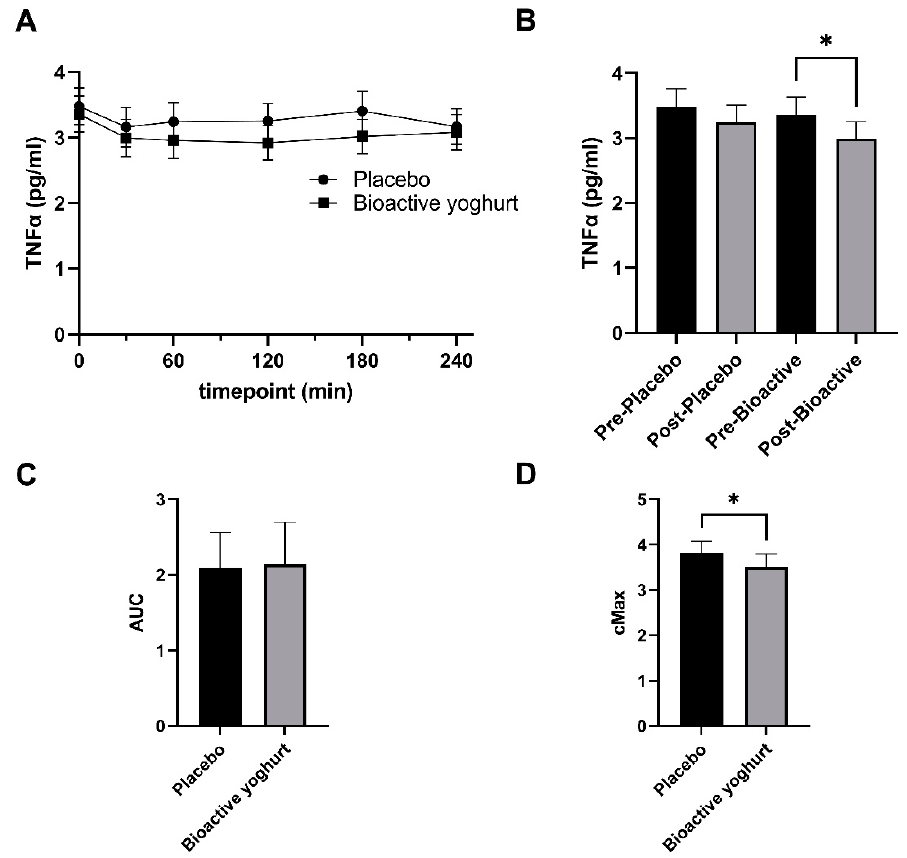
Figure 2. Plasma TNF α . Plasma was collected from participants at baseline and after yoghurt consumption and measured for TNF α . TNF α represented as ( A ) Timepoints ( B ) before and after yoghurt consumption ( C ) AUC and ( D ) Maximum concentration (C max ). Data represented as mean and SEM. * represents statistical significance ( p < 0.05). n =